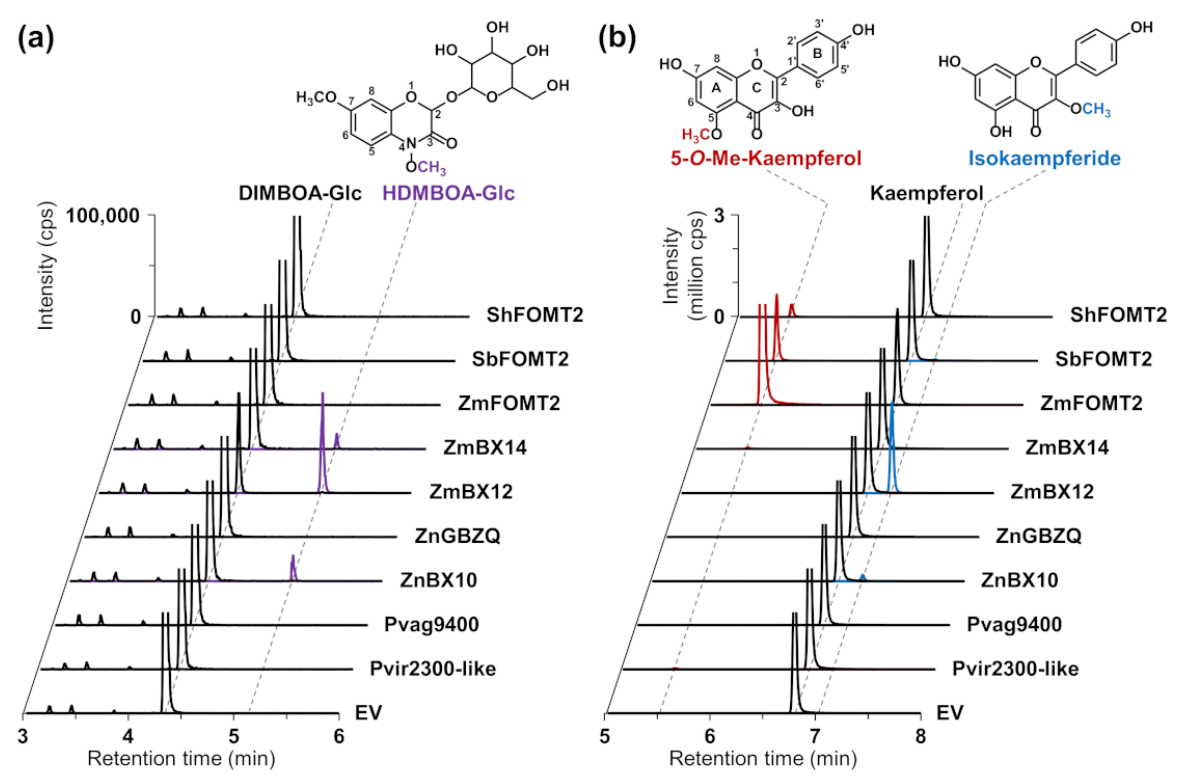
Figure 2. Activity of enzymes in the FOMT2 -like group. The purified recombinant enzymes as well as an empty vector control (EV) were incubated with the potential substrates DIMBOA-Glc ( a ) and kaempferol ( b ) in the presence of the cosubstrate S -adenosyl- L -methionine (SAM). Reaction products were analyzed by LC–MS/MS. Chromatograms of specific MRM transitions (see Methods section) are shown. In the upper part, the structures of the enzymatic products are shown with the attached methyl groups highlighted in purple (HDMBOA-Glc), red (5- O -methylkaempferol), and blue (isokaempferide), respectively. All assays were performed in technical triplicates.